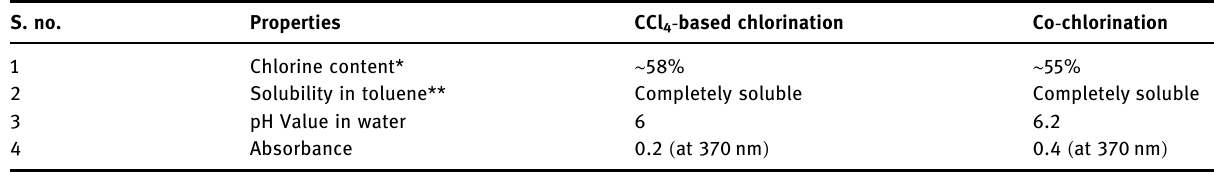
Table 4: Comparison between LDPE chlorinated in CCl 4 and para ffi n ( post separation ) S.